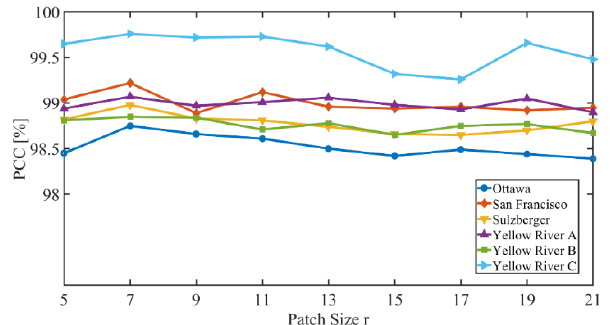
Figure 18. The PCC value with different values of r.